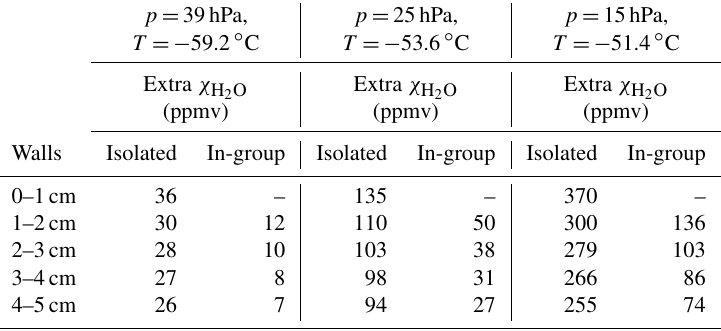
Table 4. Results for ice-layer evolution in the stratosphere due to sublimation. The “isolated” simulations refer to isolated 1cm long rings in the flow direction covering the entire inner circumference of the intake tube. These 1cm long rings start at different distances from the rim of the intake tube down to 4cm. Results are given as an extra H 2 O mixing ratio from the reference, which was χ H “in-group” simulations consider ice coverages of different lengths, all starting at the rim of the intake tube. For these simulations, extra χ H is calculated as differences from subsequent simulations. p = 39hPa,